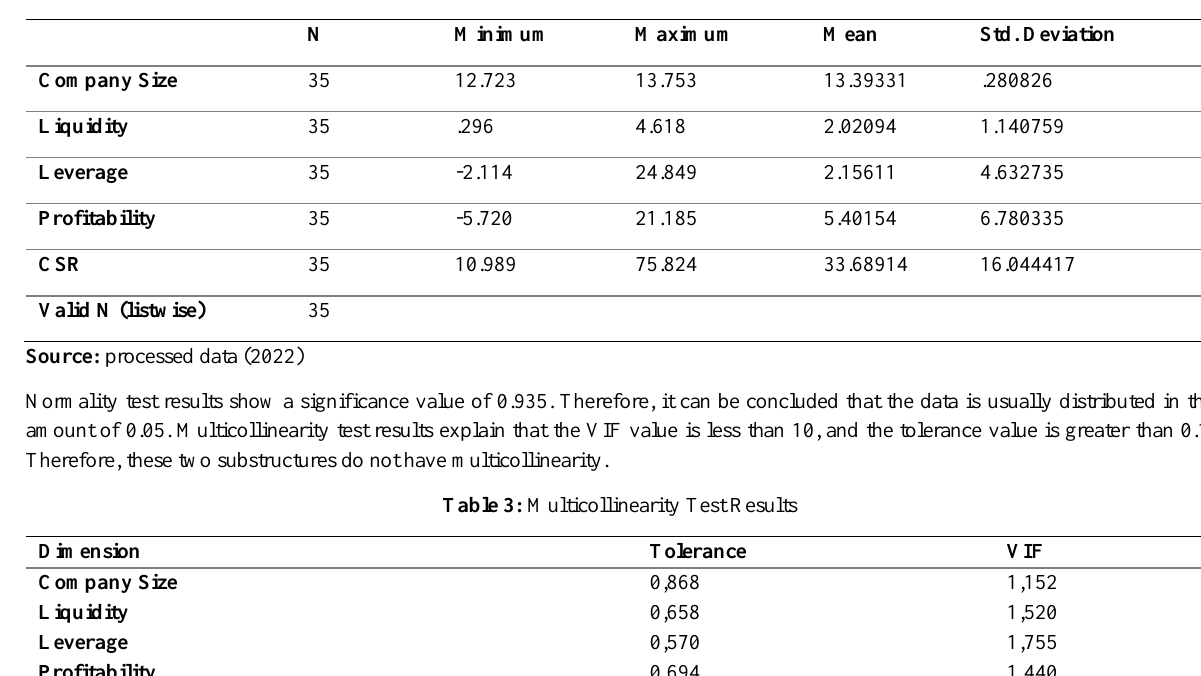
Table 2: Descriptive Statistical Analysis Test Results